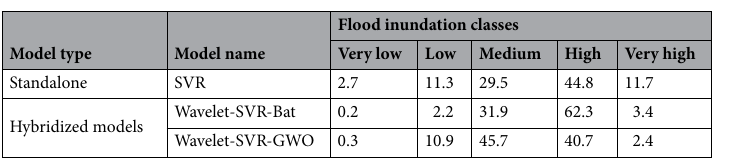
Table 3. Relative distribution of flood inundation classes from different